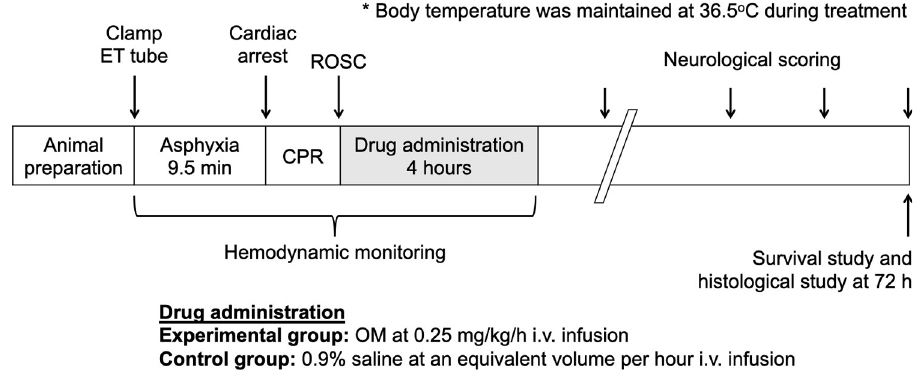
Fig 1. Study design and protocol for inducing cardiac arrest, resuscitation, drug administration, and monitoring.